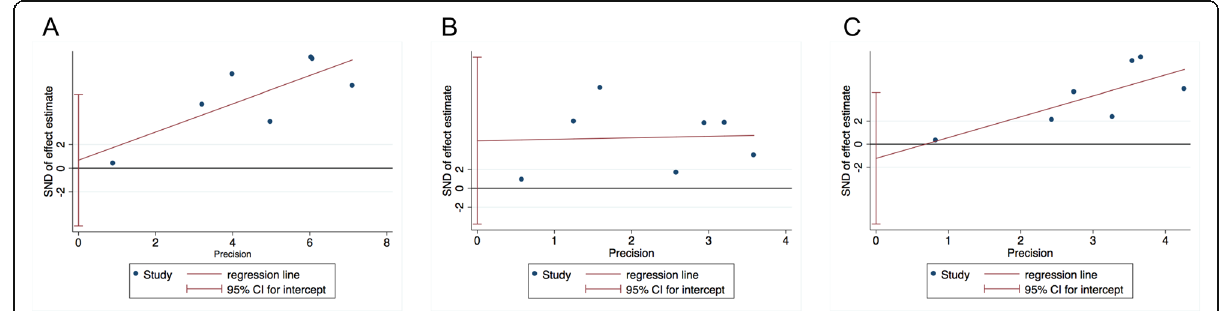
Fig. 5 The Egger linear regression test for c.-3279 T > G (rs4124874) compared with the ( a ) allele model, b the contrast of GG vs TT and c GT + GG vs TT to show publication